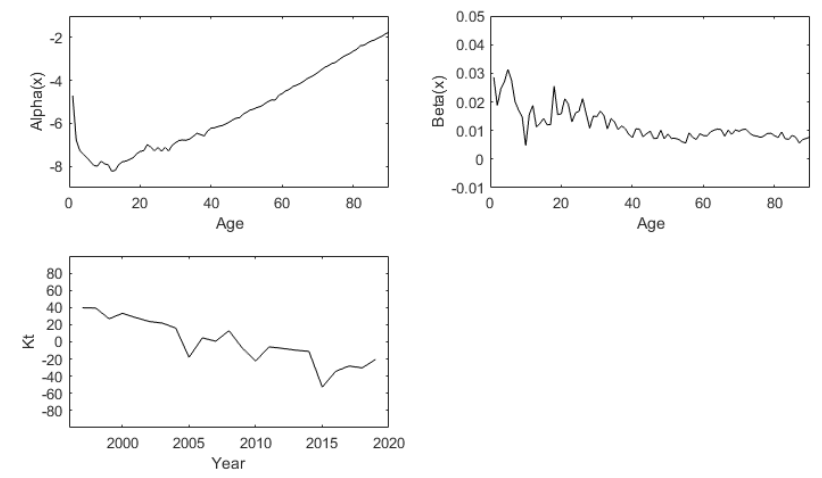
Figure 2. Fitted components of basic LC method for males of China (1996:2019).